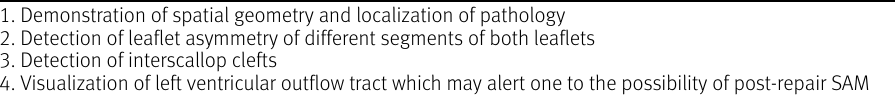
Figure. 3 A transgastric short axis section of the mitral valve indicates a cleft through which systolic flow is observed. The real-time 3D image of the anterior leaflet (B) clearly demonstrates width and height of the cleft in anterior mitral leaflet. Superiority of 3D echocardiography in mitral valve